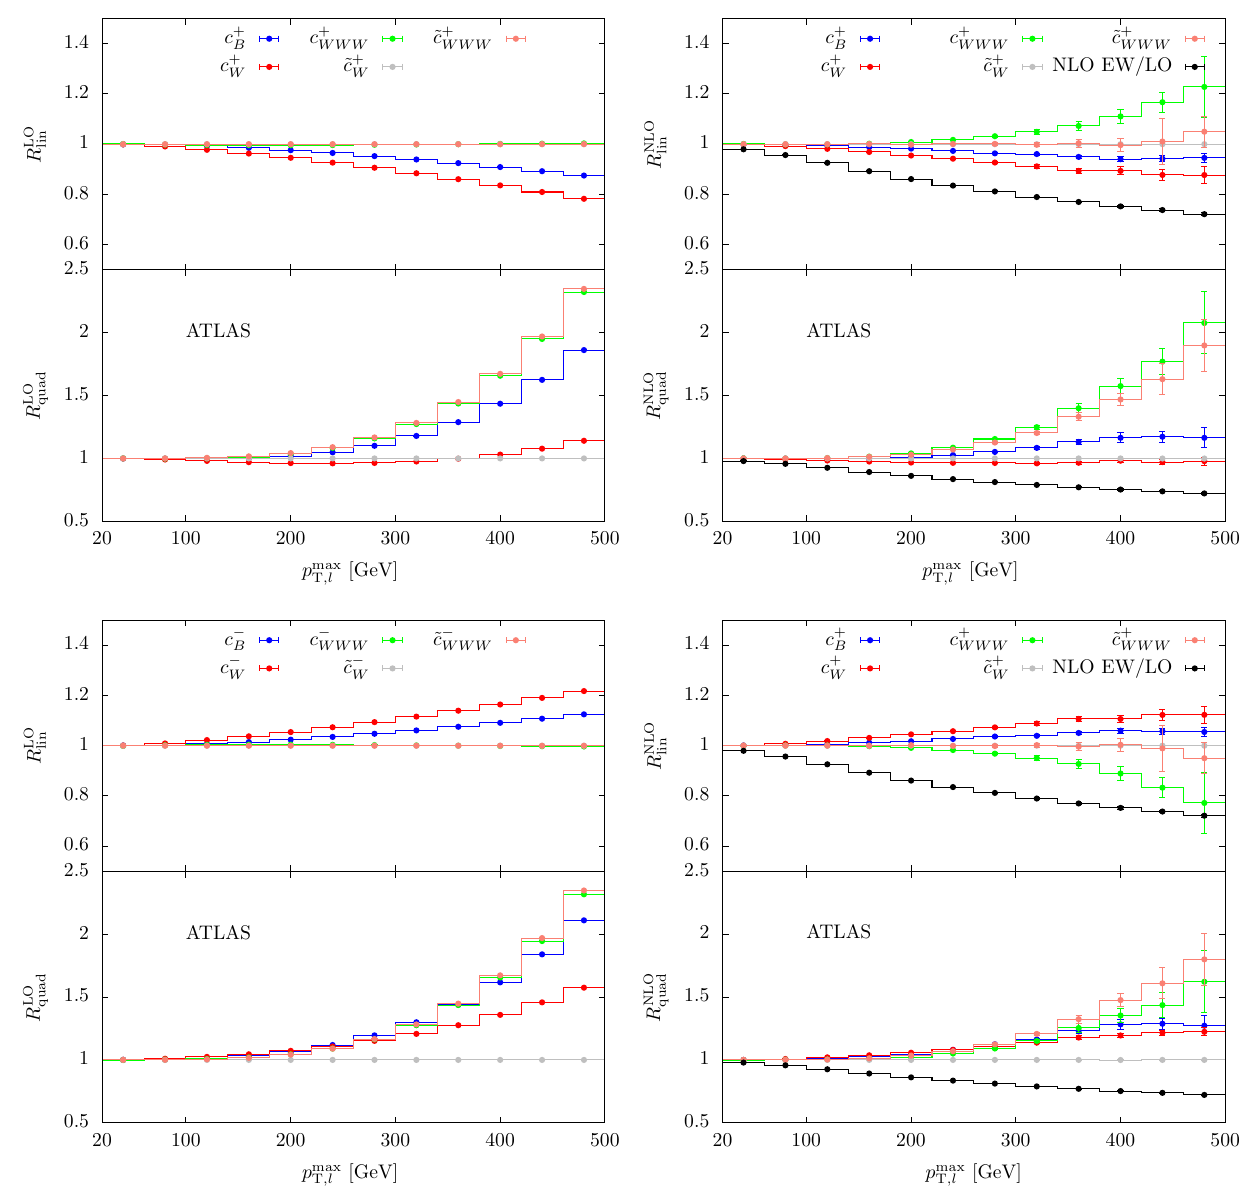
Fig. 7 Ratio R LO ( NLO ) asafunctionofthetransversemomentumofthe lin ( quad ) hardest lepton for the process pp → e + ν e μ − ¯ ν μ in the ATLAS setup of Eq. (4.4). The ratios between the theoretical predictions including both the aTGCs and the SM results at LO (left plots) are compared to the ratios at NLO QCD accuracy (right plots). In each plot the upper panel